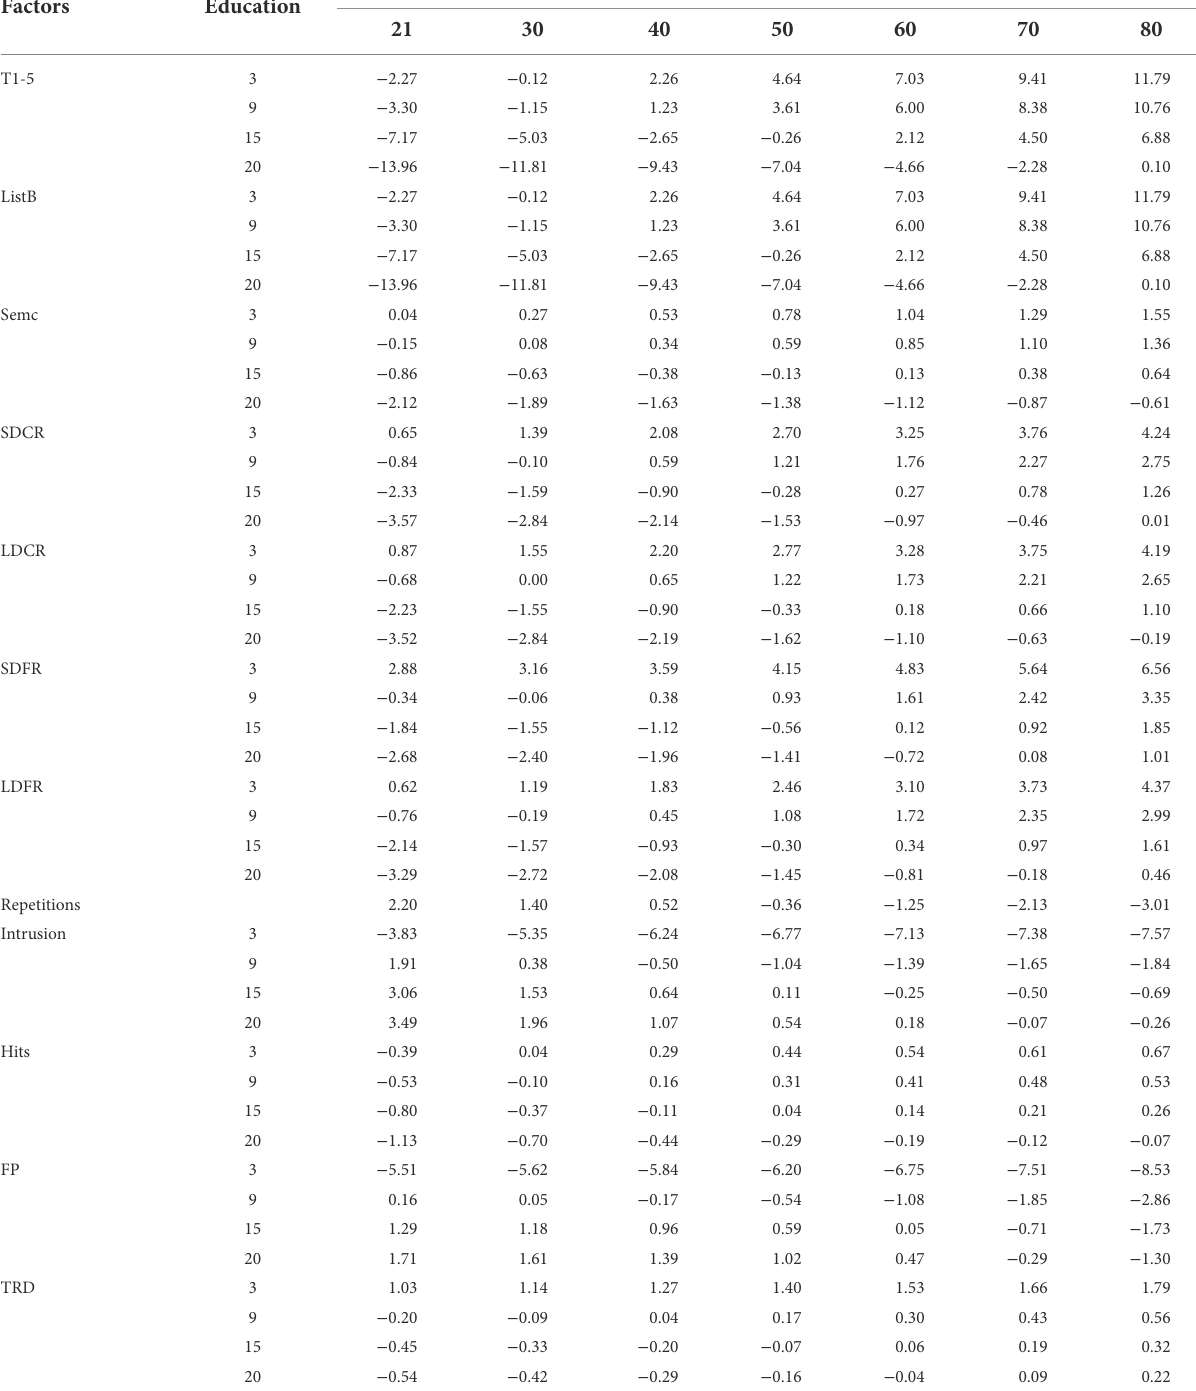
TABLE 6 Adjustment grids according to age and education for the CVLT-II